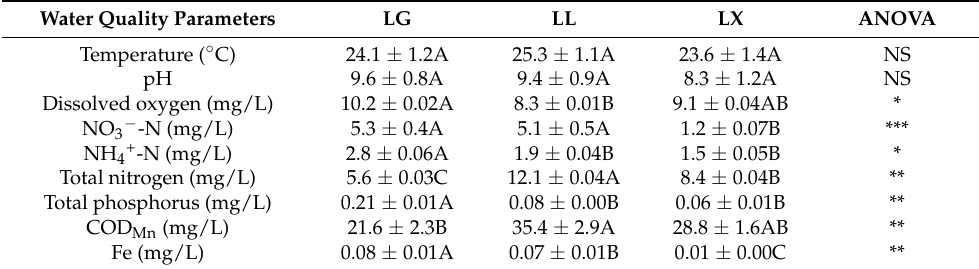
Table 2. Water quality parameters associated with Geming lake (LG), Lianhu lake (LL), and Xingqing lake (LX) in Xi’an City, Shaanxi Province, China.